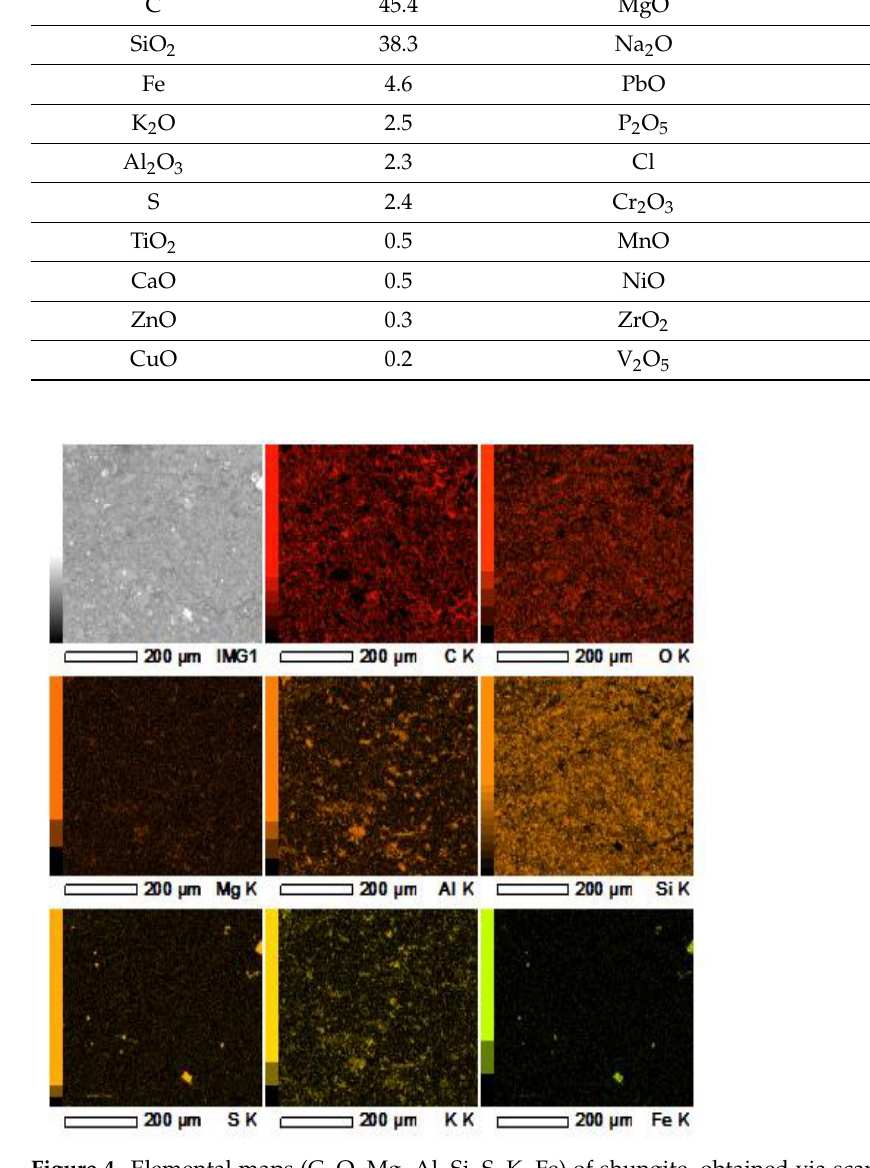
Figure 5. Measurement of shungite via thermogravimetry-differential thermal analysis under air conditions and at 10 °C/min.